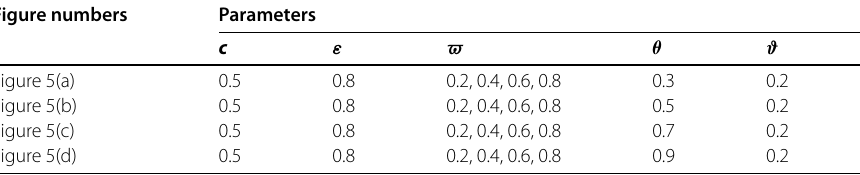
Table 2 Different parameters for the anomalous diffusion model Figure